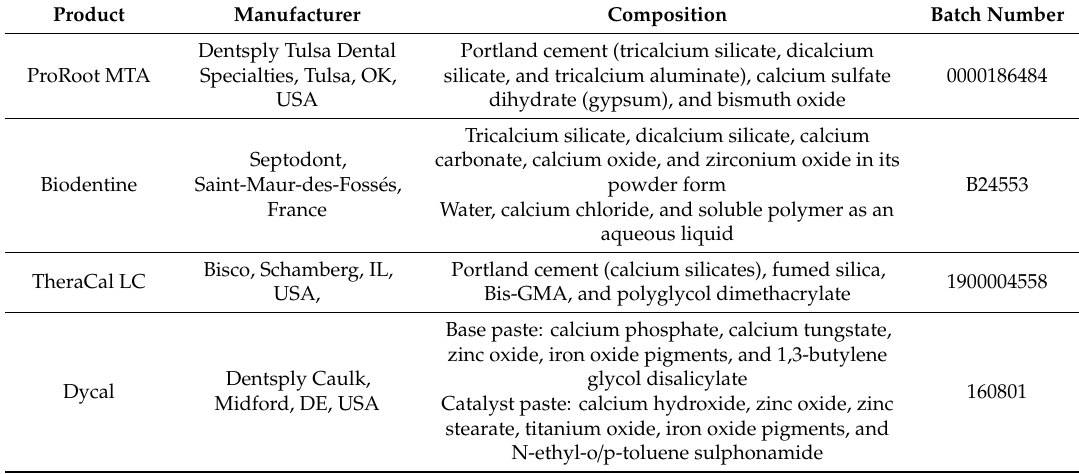
Table 1. Manufacturers and chemical compositions of various direct pulp capping